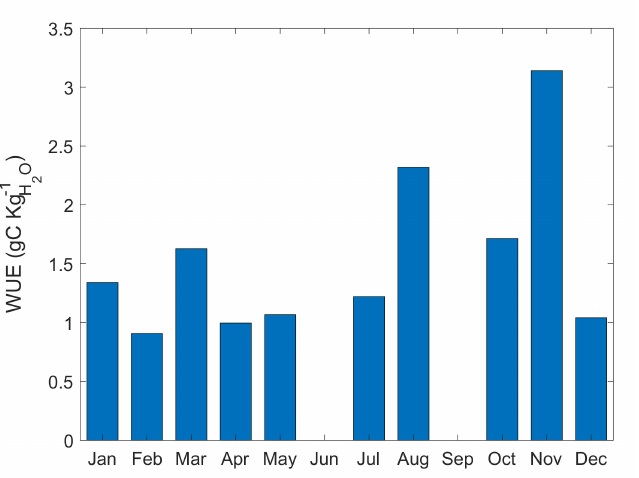
Figure 10. Annual cycle of monthly averages of WUE (gC Kg − 1 H2O ) for the sun-exposed coffee plantation based on the EC measurements for 2020. Note that the largest WUE values were observed for the months in which the number of heavy rainfall events was